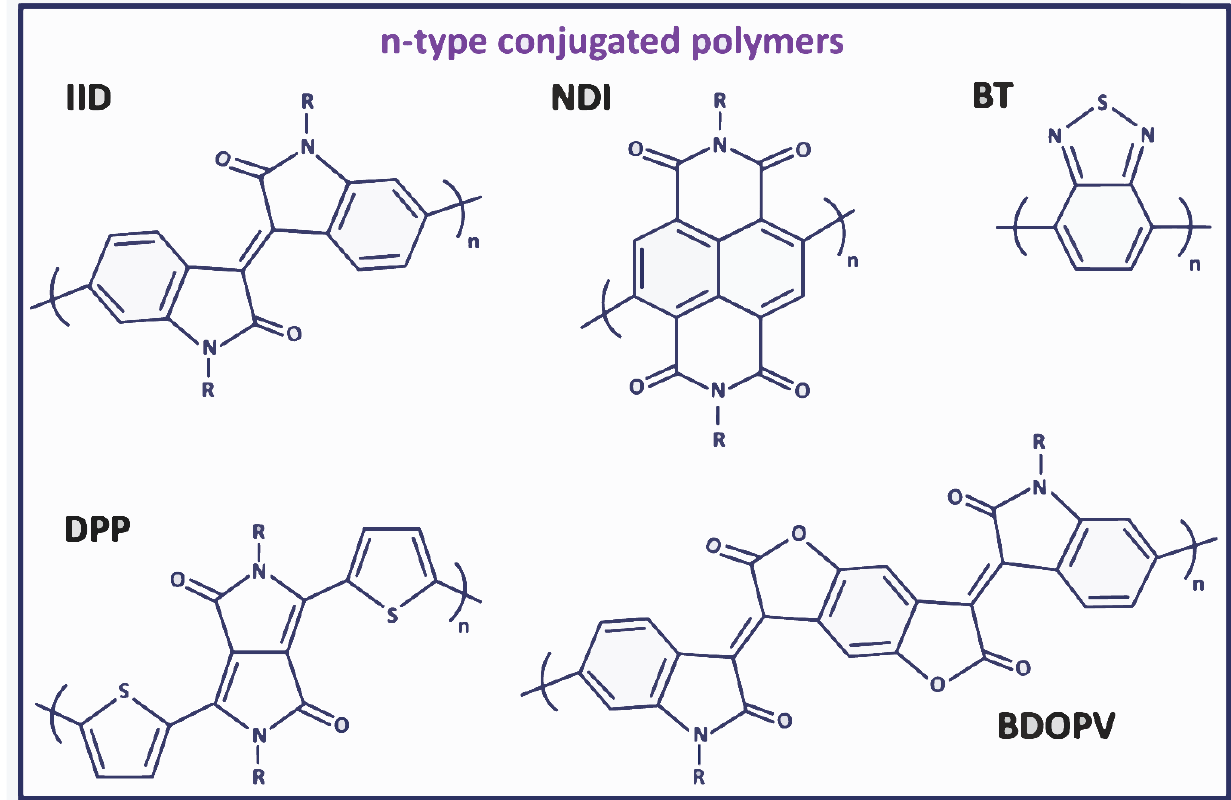
Figure 6. The chemical structure of the most applicable n ‐ type conjugated polymers, such as isoindigo (IID), naphthalene diimide (NDI), benzothiadiazole (BT), diketopyrrolopyrrole (DPP), and benzodifurandione ‐ based oligo (p ‐ phenylene vinylene) (BDOPV).